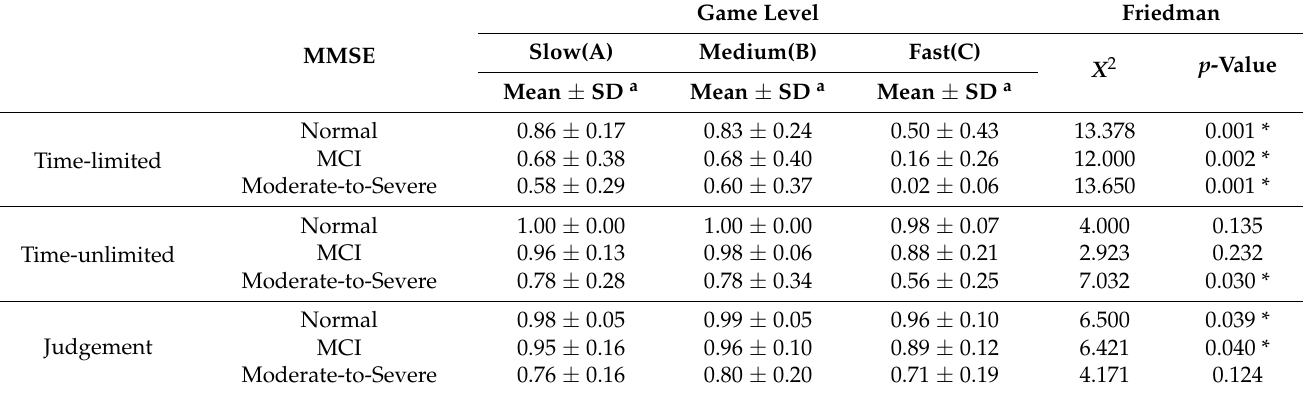
Table 9. Posterior comparisons of the results of different game speeds by test scores using the Friedman Test.